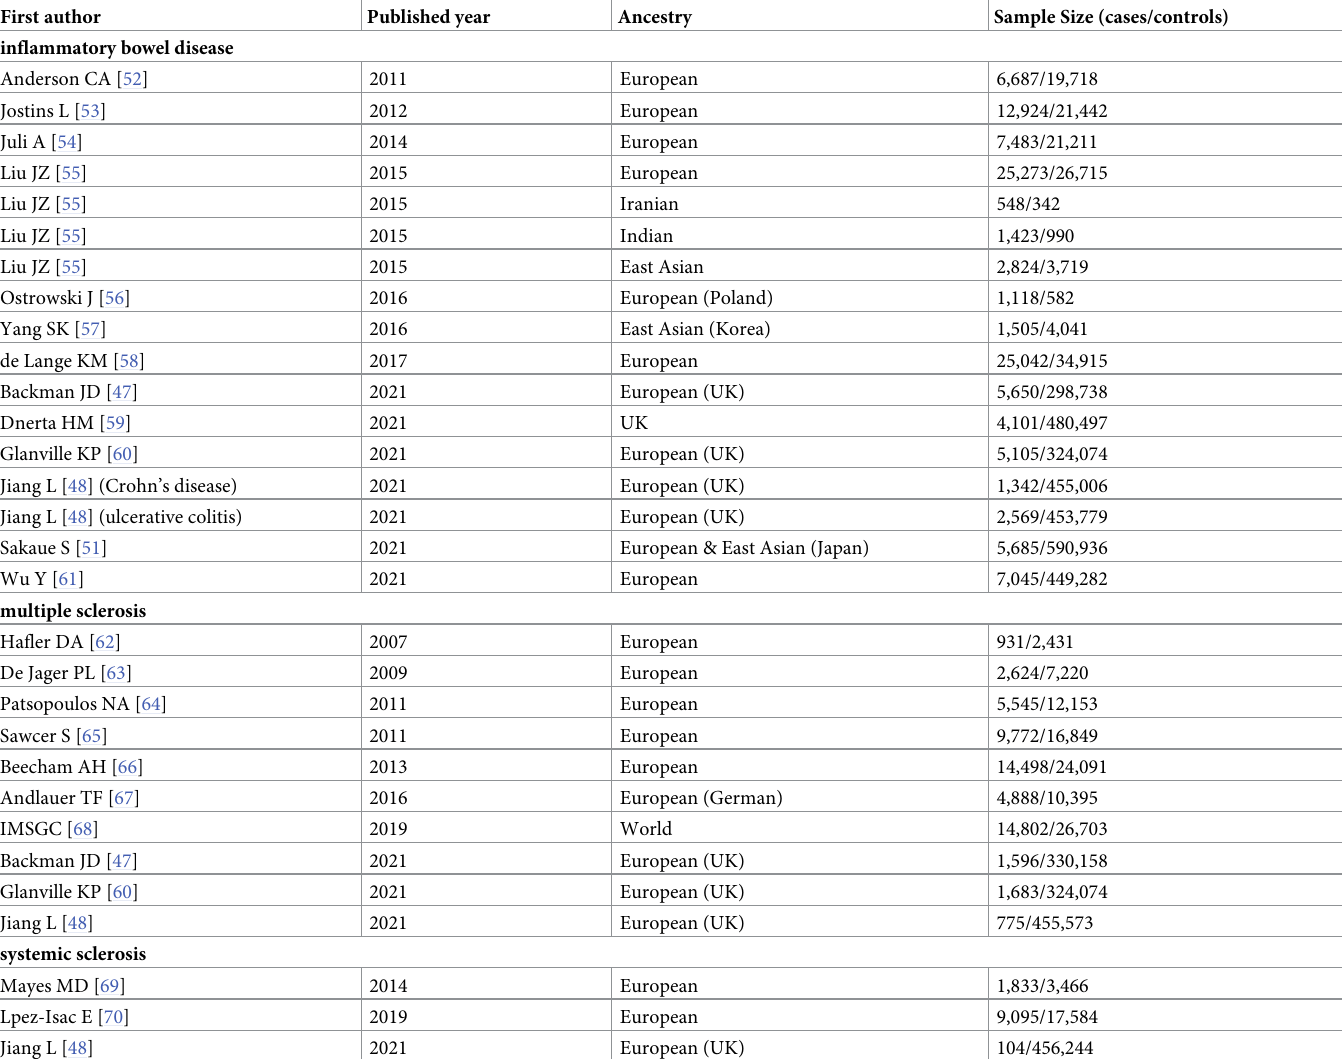
Table 3. The information of studies on other autoimmune disorders included in the